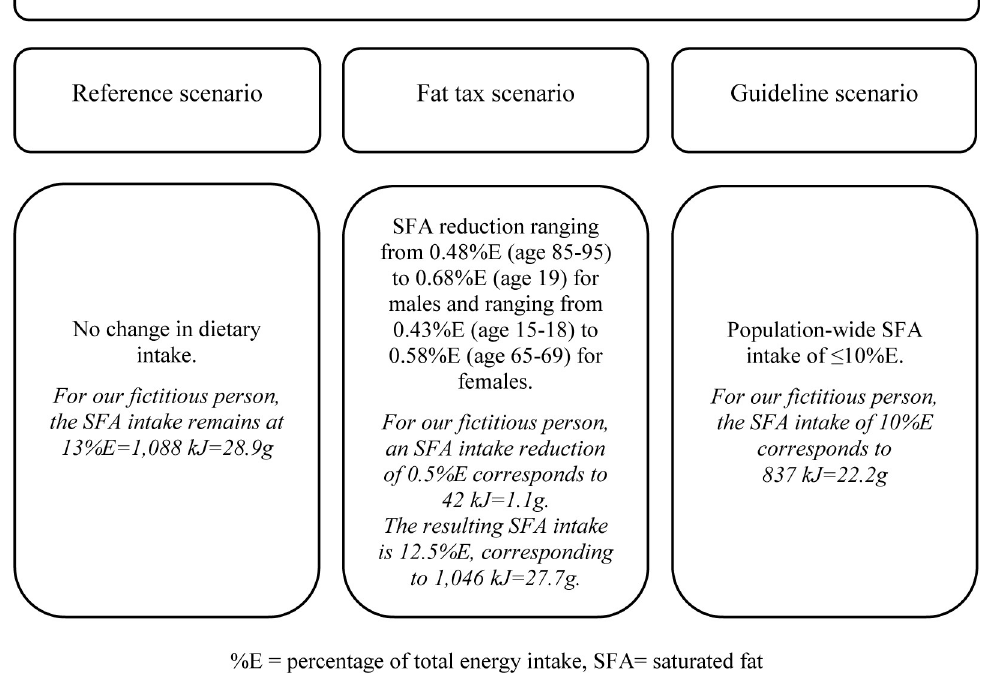
Fig 1. Illustration of reference, fat tax and guideline scenario.